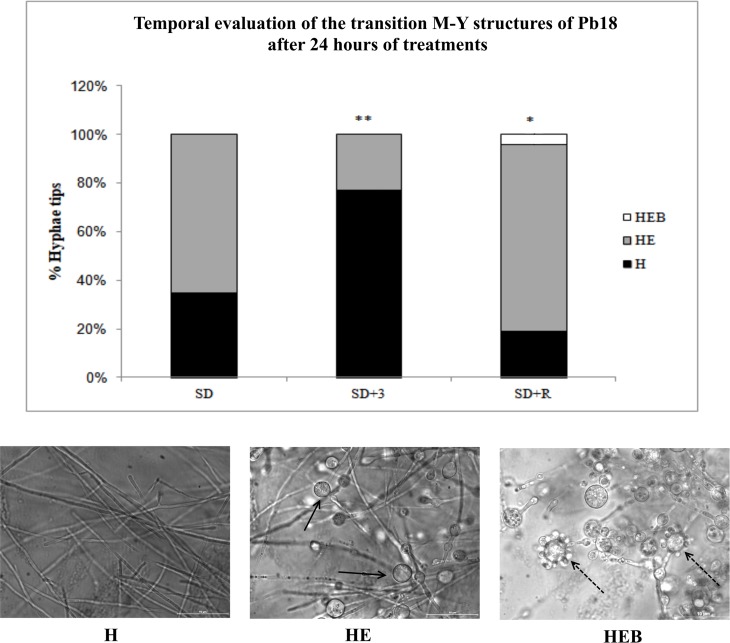
M-Y transition showed different rates for the typical transition structures along the first 24 hours.(A) Graphical summary of the rate of morphological changes in hyphal tips during the first 24 hours of progression through the M-Y transition at 36°C in the absence of modulators (SD) or presence of 0.2 μg ml-1 rapamycin (SD+R) or 10 mM 3-MA (SD+3). (B) H—Hyphae without enlarged tips; HE—Hyphae with enlarged tips; HEB—Hyphae showing enlarged tips with bud. The arrow indicates HE structure, and the dashed arrow indicates HEB structure. Scale bar = 10 μm. * means p>0.05 and ** p>0.01.